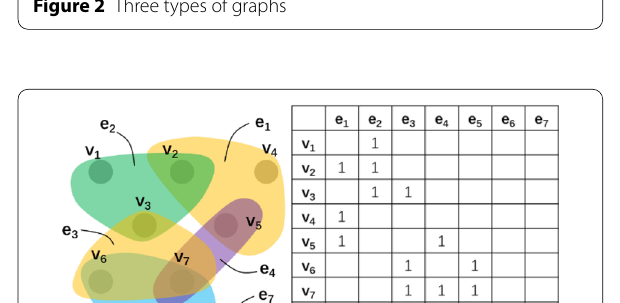
Figure 2 Three types of graphs